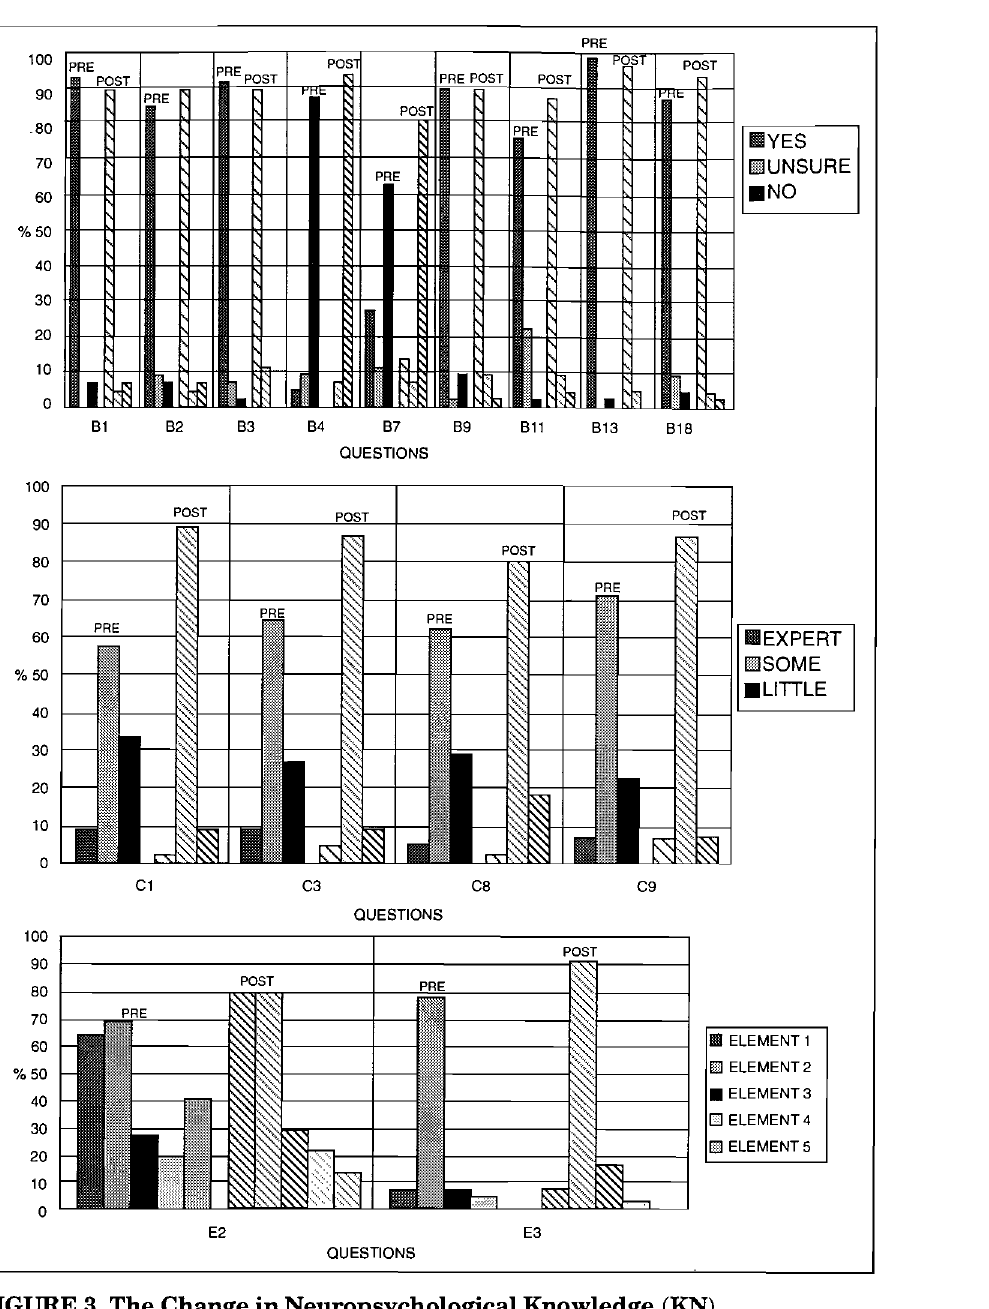
FIGURE 3. The Change in Neuropsychological Knowledge